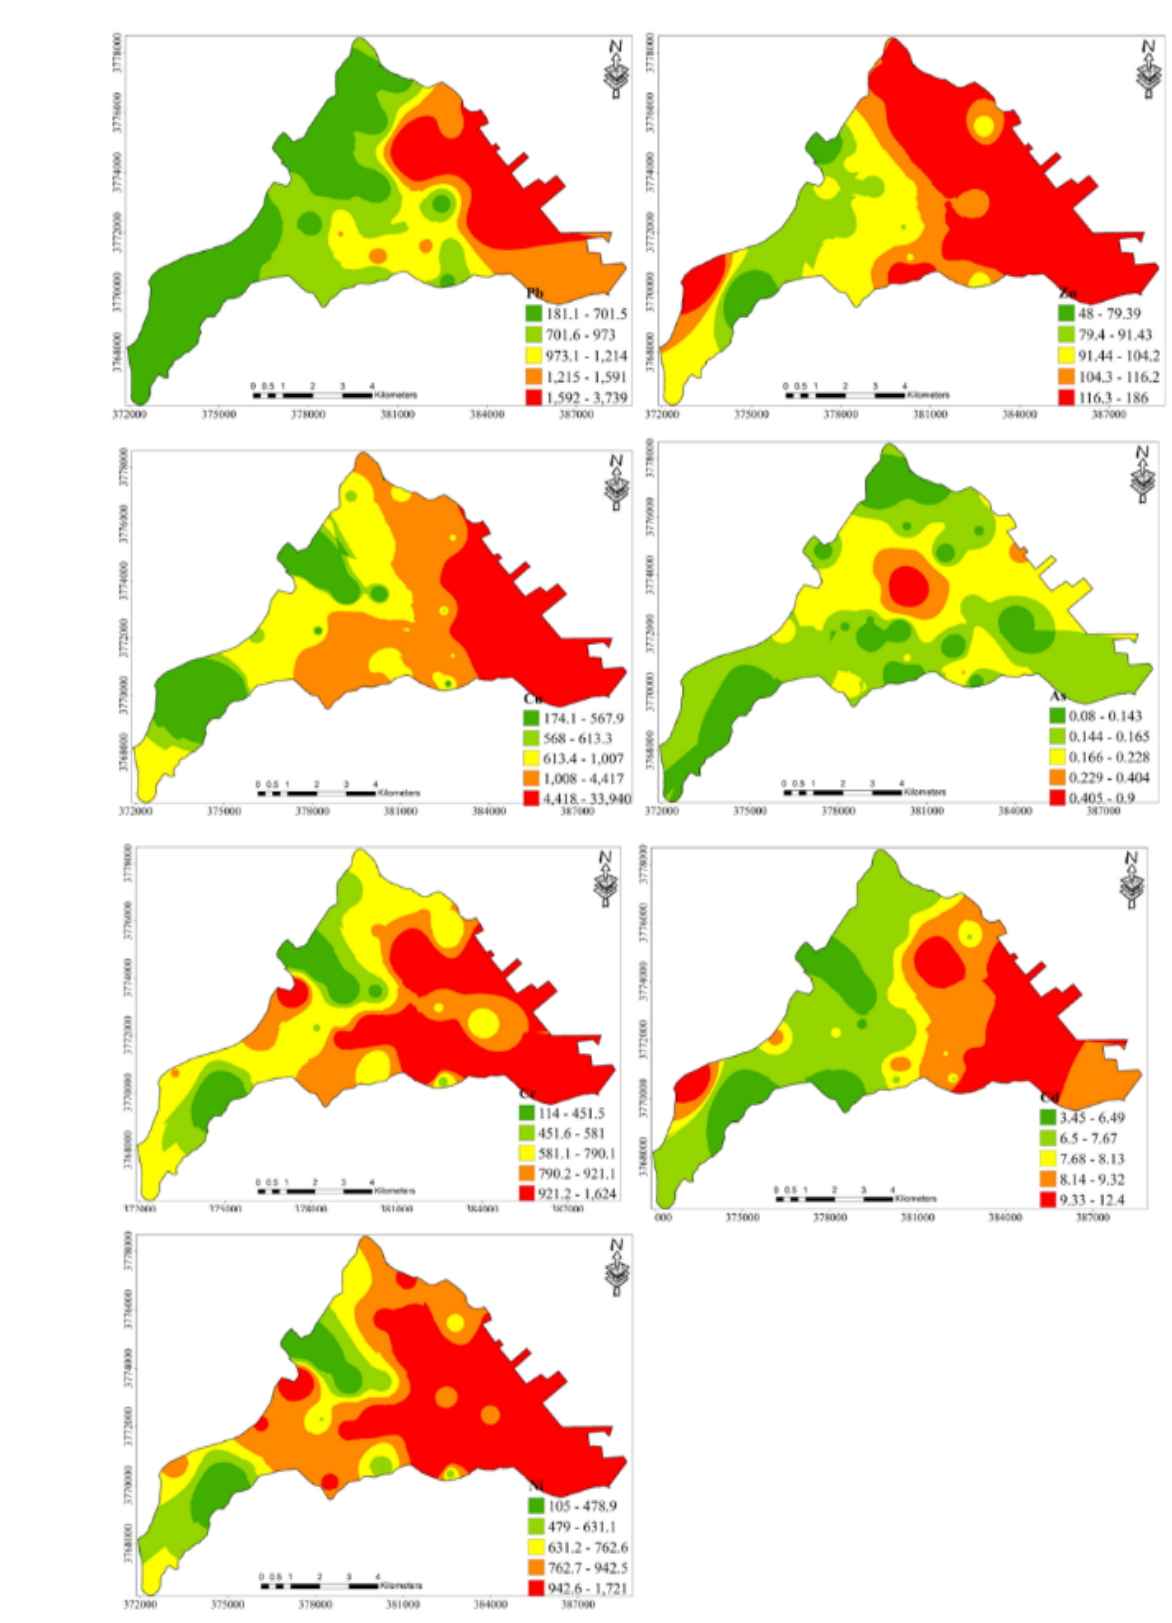
Figure 2. Spatial distribution pattern of toxic element concentrations in Arak